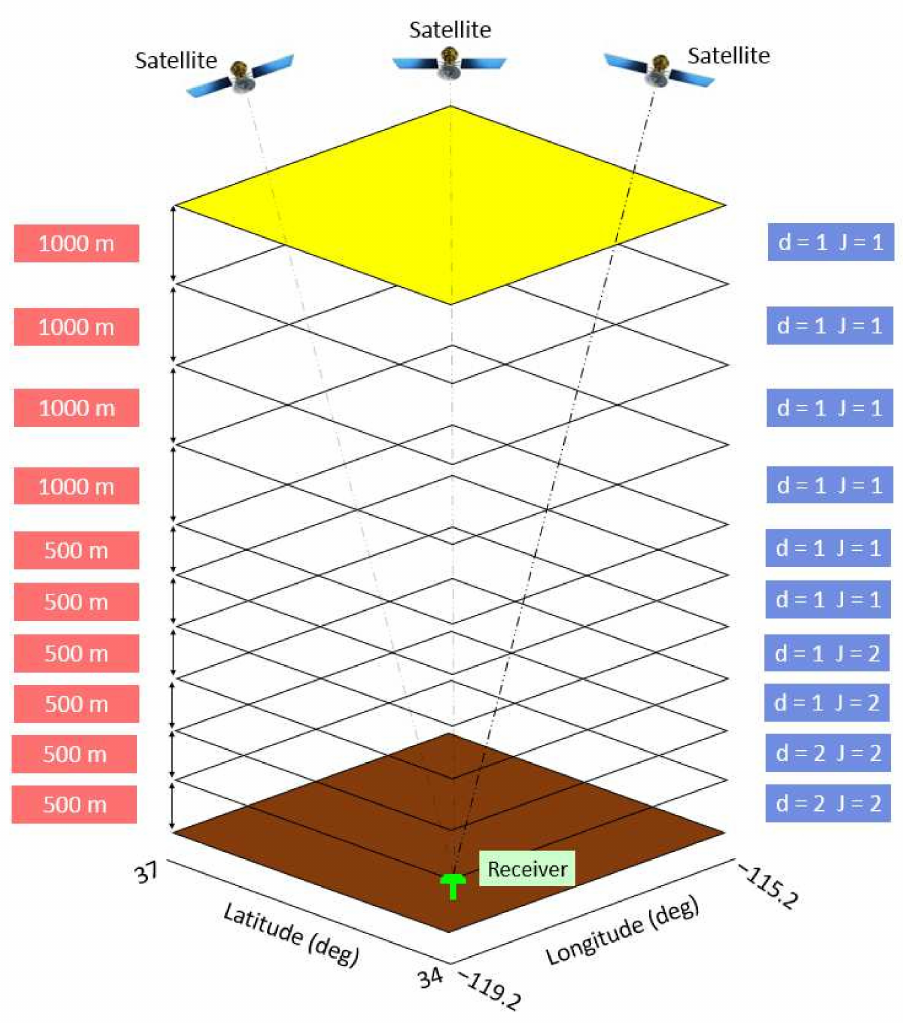
Figure 6. Tomography model together with a schematic diagram of considered degrees and levels at different vertical